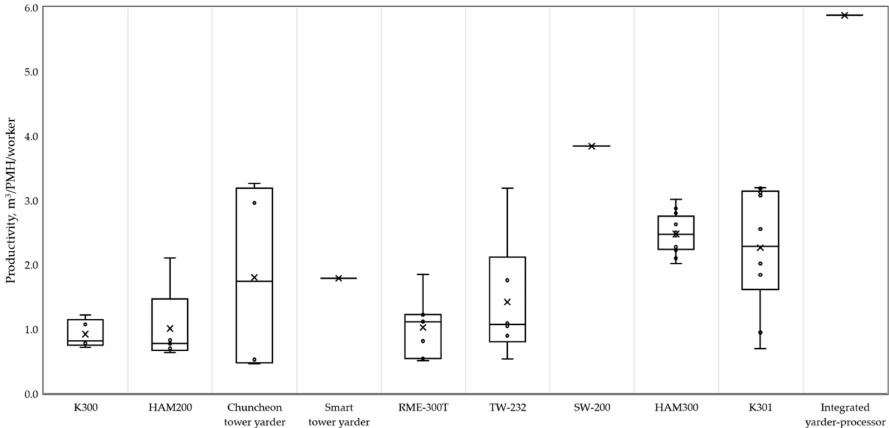
Figure 5. Summary of the variation in productivity among several tower yarders. The circles are data points, and the × is the mean